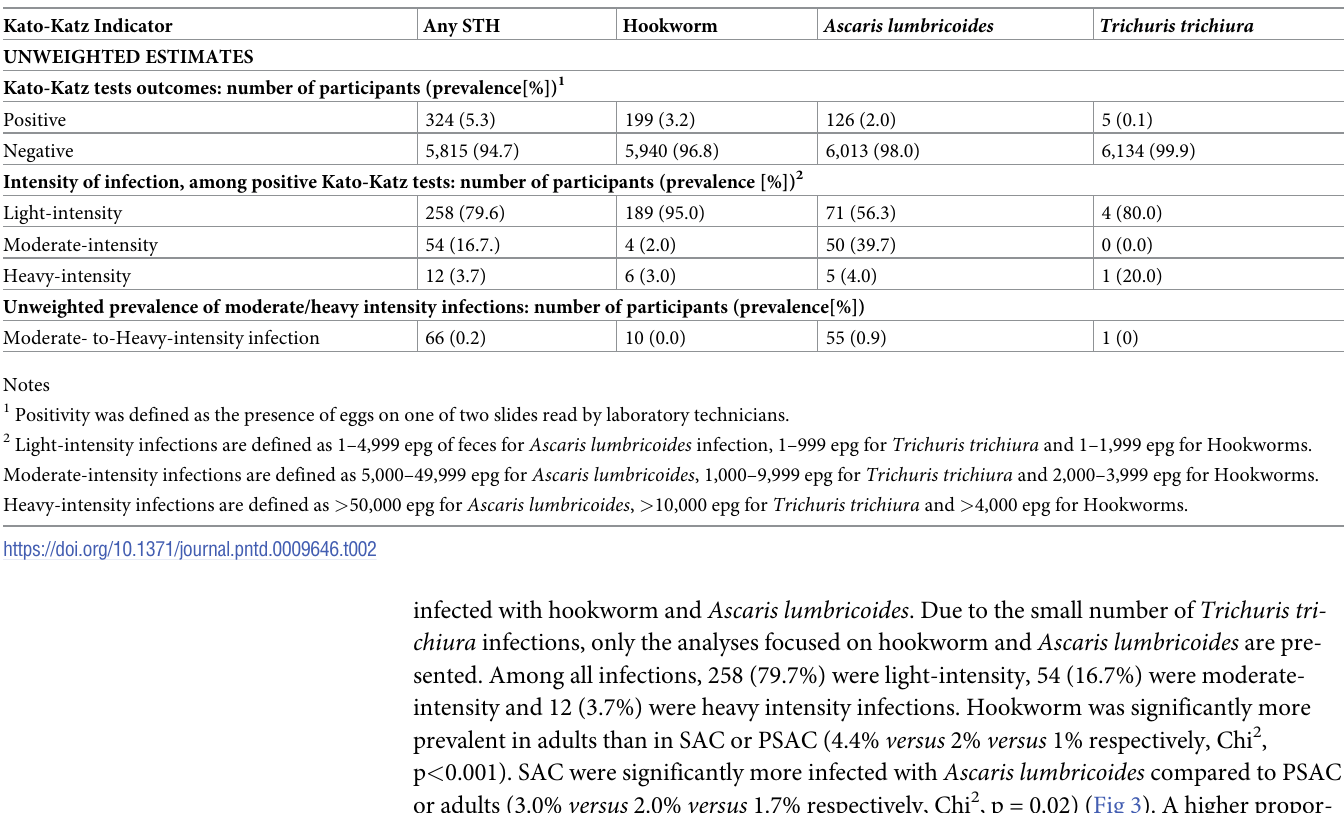
Table 2. Unweighted STH prevalence and intensity of infection by Kato-Katz testing. N = 6139. Kato-Katz